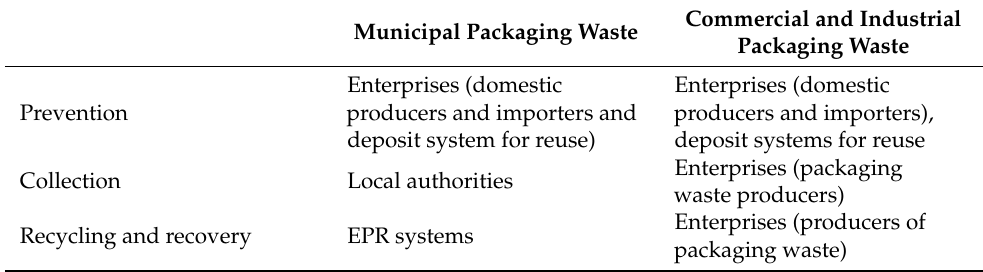
Table 5. Responsibilities for prevention, collection, recycling, and recovery in Portugal.